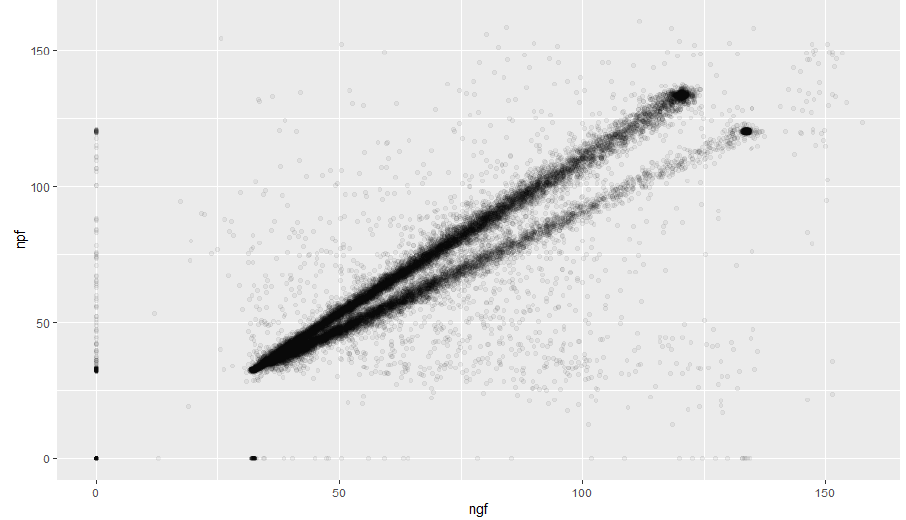
Figure 8. Mutual dependence of the loads on feed motors. Source: Own study.